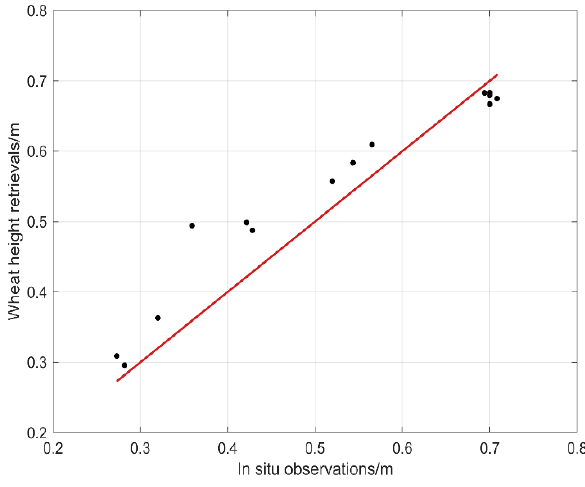
Figure 17. Correlation between the proposed method and wheat height. Table 3. Wheat height retrieval precision